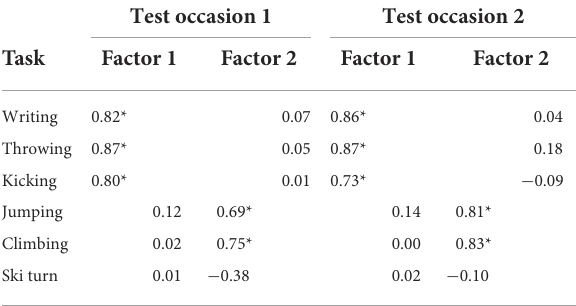
TABLE 2 Exploratory factor analysis on the first and second test occasions.